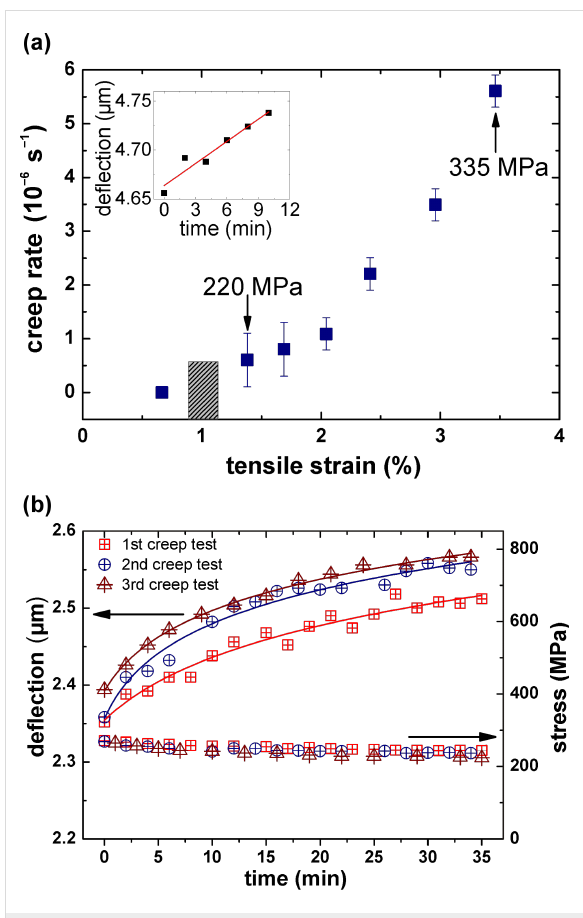
Figure 5: (a) Creep rate as a function of tensile strain; creep deforma- tion can be only observed above a certain strain, e.g., ~1%. Inset: The deformation at the beginning of creep has a linear characteristic. (b) Three creep deformations were recorded at room temperature, the second test was performed 200 min after the first unloading, and the third test was performed 160 min after the second